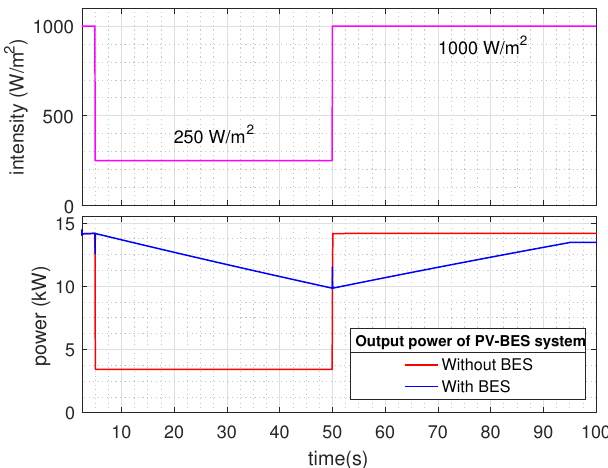
Figure 12. Top: solar irradiance, Bottom: powers of the PV and BES system response to the solar irradiance.